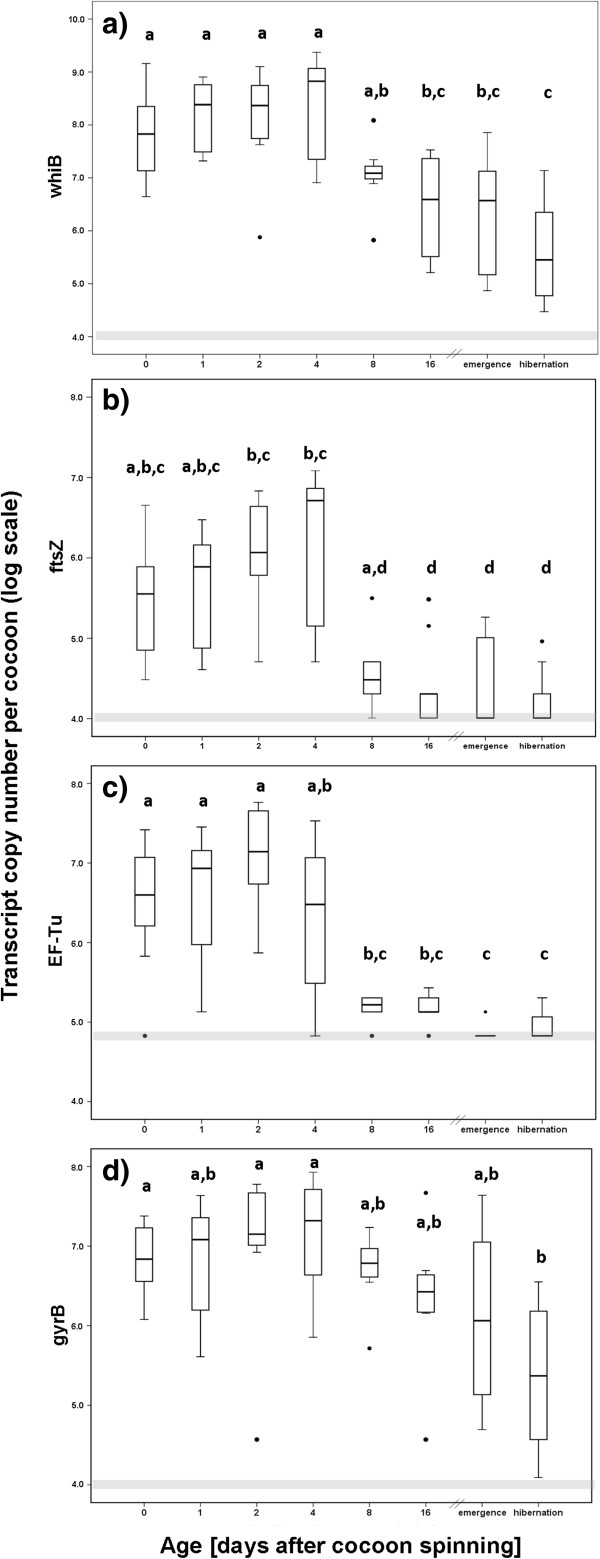
Expression levels of different housekeeping genes and the whiB sporulation regulatory gene on beewolf cocoons at different time points after cocoon spinning, obtained from RT-qPCR assays (on log scale). a)whiB; b)ftsZ; c)EF-Tu; d)gyrB. The different groups refer to days after cocoon spinning; emergence: eclosion of adult beewolf from the cocoon (about four weeks after cocoon spinning), hibernation: eclosion after diapause (about 8 months after cocoon spinning). Bold lines represent medians, boxes comprise the interquartile range, bars indicate minimum and maximum values, outliers are given as dots. Different letters above the boxes represent significant differences (ANOVA with Tukey post-hoc tests: df=7, p<0.05 for all analyses), The grey bar indicates the level of unspecific amplification as obtained from the qPCR negative control.